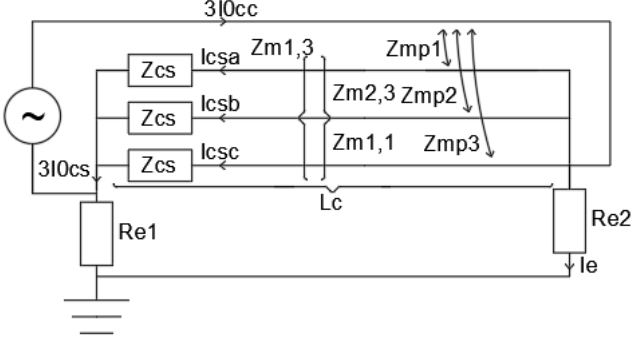
Figure 6. Coupling impedances in case of earth fault in cable, based on [50].